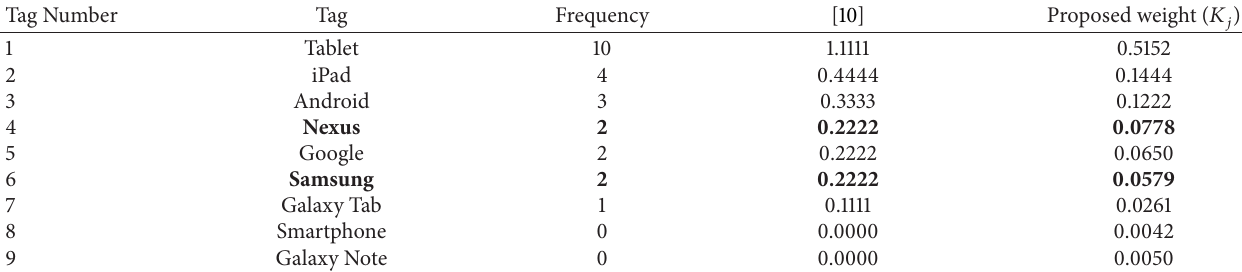
Table 2: Comparison with an existing study and the proposed method.